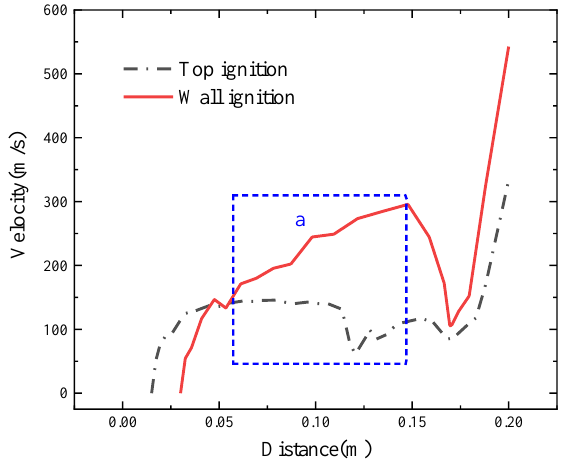
Figure 11. Flame propagation speed in the hot jet tube of two ignition positions.